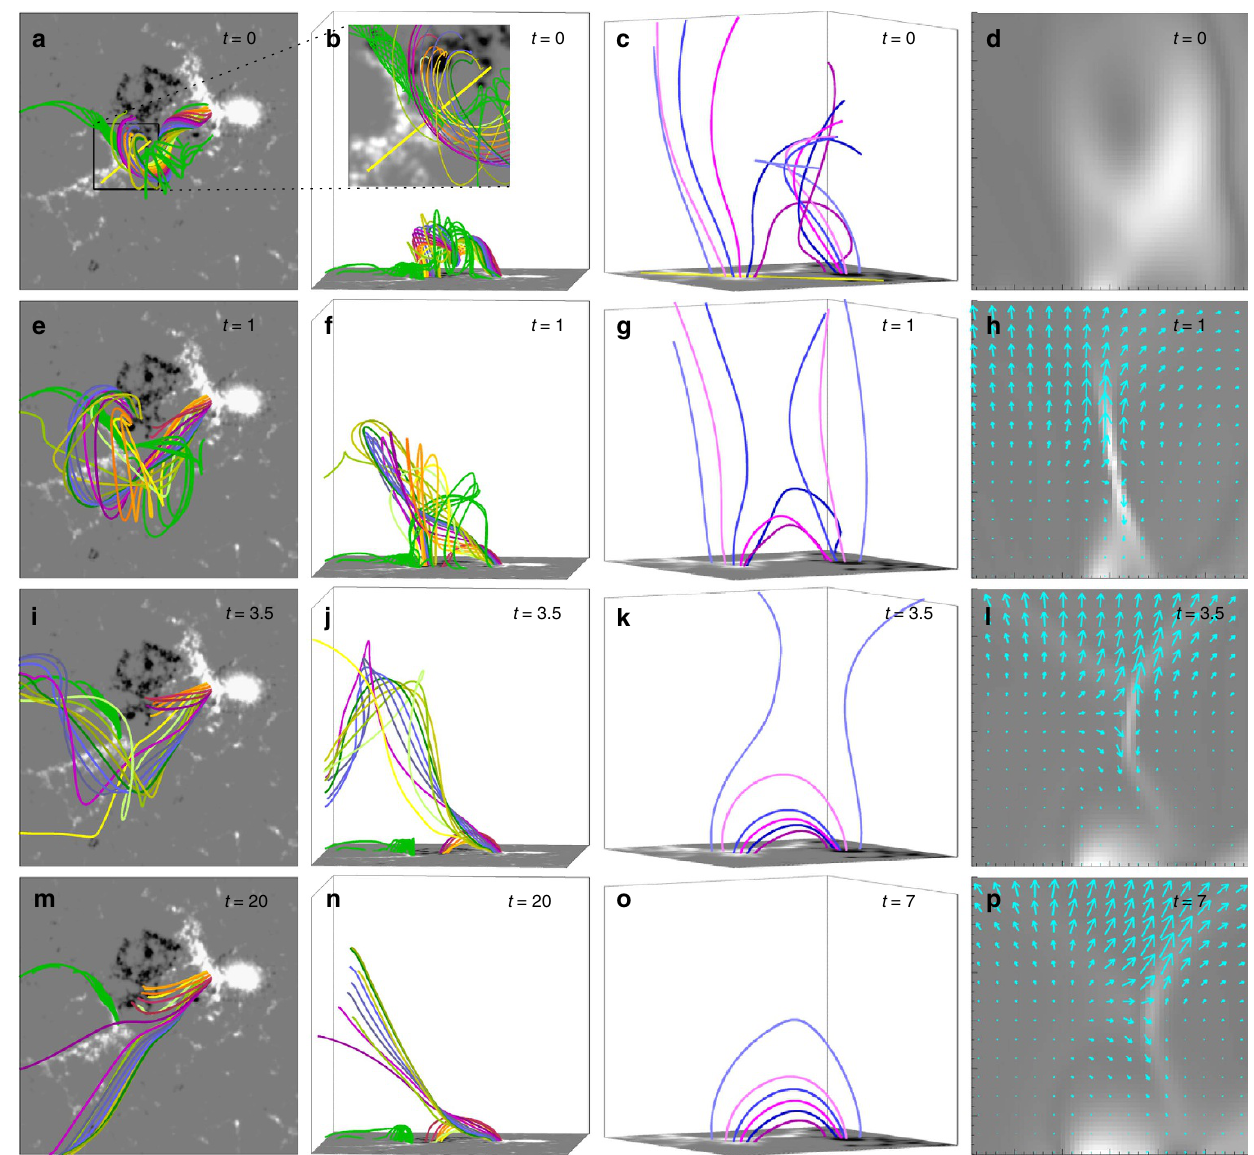
Figure 7 | MHD simulation of the confined filament eruption and magnetic reconnection. The left two columns show field lines of the fully erupting western flux rope section (rainbow colours) and the largely stable eastern flux rope section (green) and the line-of-sight magnetogram in a cube of 0.25 R } per side. The inset at t ¼ 0 indicates the area shown in the third column, and the yellow line shows the position of the vertical cut plane in the fourth column. The third column shows selected field lines in the area of the observed reconnection in a cube of 0.06 R } per side. Field lines rooted in positive photospheric flux (white) initially mostly extend to AR 12179 eastward of AR 12178 (Fig. 6b), while field lines rooted in negative flux (black) initially mostly join the unstable western flux rope section. The fourth column displays the current density and in-plane velocity vectors in a vertical cut through the reconnecting current sheet (0.06 R } per side). At t ¼ 0, the inserted, unstable flux rope is seen, with velocities set to zero. Times are given in Alfve´n time, which corresponds to B 3min when scaled to the